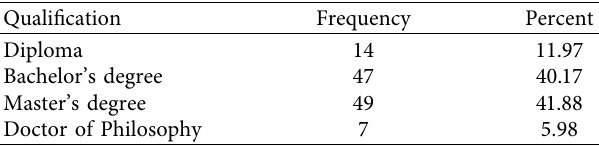
Table 2: Respondents’ educational status.